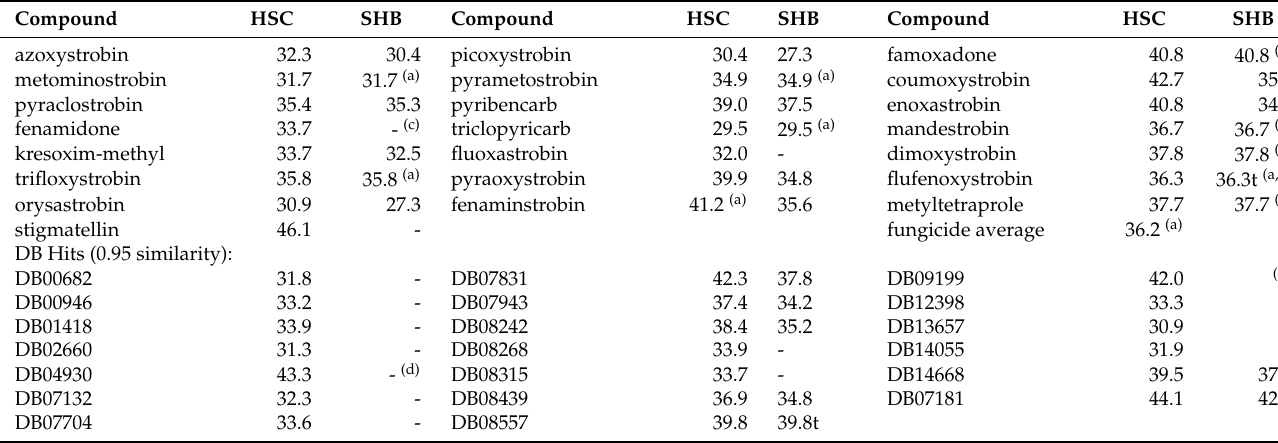
(a) HSC conformation is at the same time SHB conformation. (b) Attained only with repeated docking with 200 ga runs and within 20Å. (c) No conformation (among 100 + 200 possible) with specific H-bond and will not be MD simulation runs. (d) DB09199: No SHB conformation, but hit is obtained with HCS > 41.2 and HSC has an H-bond with the protein (Tyr-279), so exceptionally it will be considered for MD runs. DB04930: Only in one conformation out of 100, chlorine forms an H-bond with amide